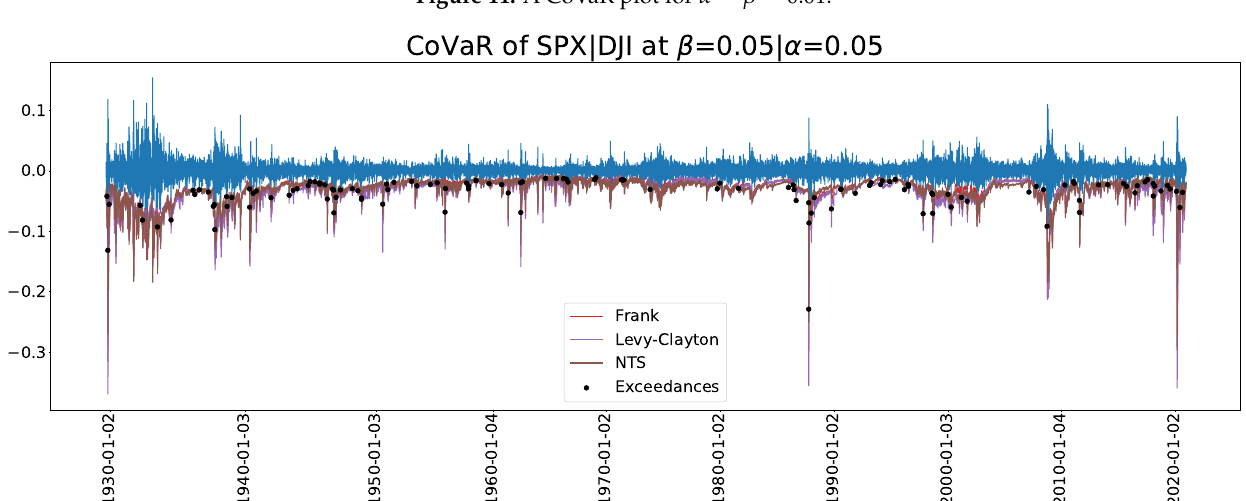
Figure 11. A CoVaR plot for α = β = 0.01.